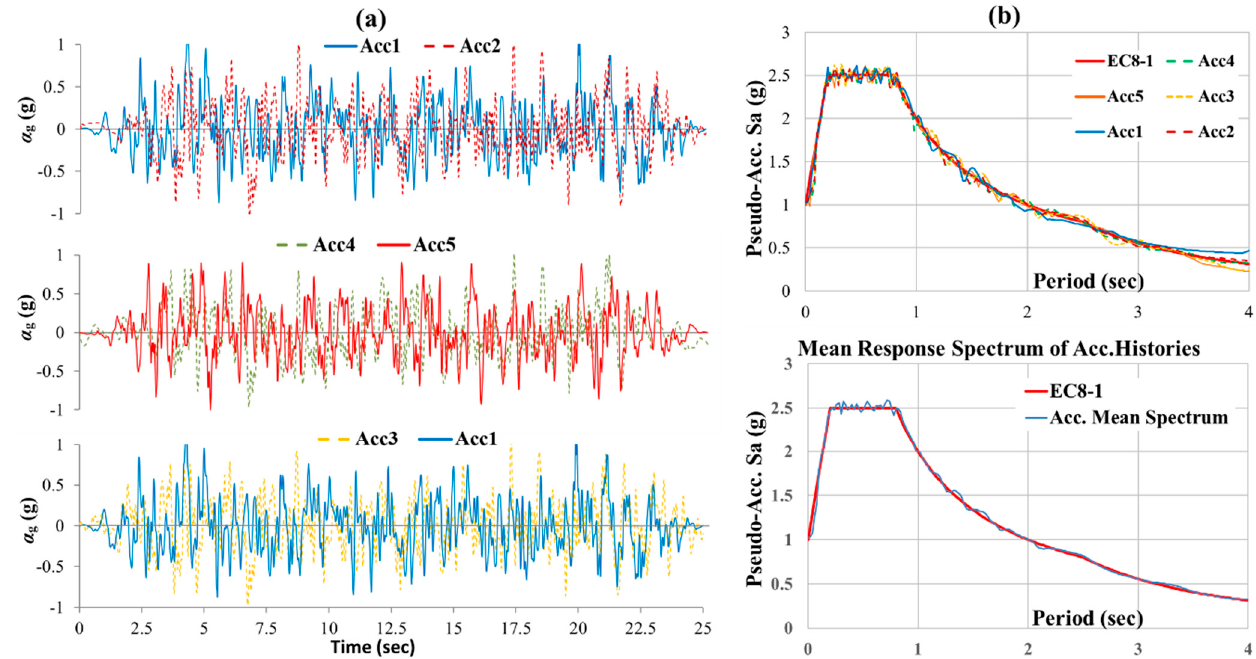
Figure 9. ( a ) Three pairs of unit-normalized artificial accelerograms ( a g · S = 1.00 · g, t d = 25 s, strong motion duration 19 s), ( b ) Elastic acceleration spectra of the 5 accelerograms and their mean acceleration spectrum relative to the design spectrum of EN 1998-1 (damping 0.05, a g · S = 1 · g and soil